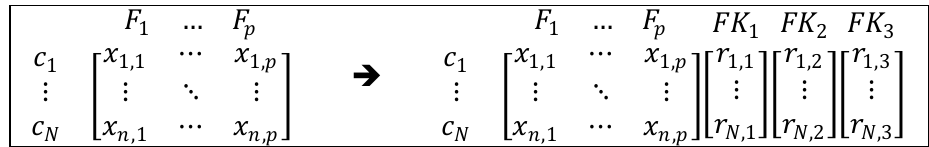
19 of 44 Figure 7. Critical differences plot of the pairwise Nemenyi comparison test for the cut-off (threshold) adaptation experiment. There are many techniques to perform feature selection, which aims to select a subset of salient features to build a prediction model. Bi et al. [99] have attempted feature selection through introducing a probe to the data by adding three randomly generated variables (fake features/columns) to the dataset. These fake features are randomly drawn from a Gaussian distribution [100]. They use a linear SVM to model the subsets at every iteration of a K-folds cross- validation, where variables with nonzero weights are selected. Any variable (feature) with an average weight below that of the fake variables is then rejected. This approach does not address weight variability, as it only compares averages. Similarly, Kursa et al. [101,102] have proposed a similar approach in which the information system (training data) is doubled, so that every feature has a shadow feature that is basically a shuffled version of the original one. Feature importance evaluation is then performed on the extended system using the RF algorithm. A K-folds CV—of at least 10-folds—is performed at every iteration, so that every feature is compared to its shadow using statistical tests to evaluate the highest performing features. The main drawbacks of this approach are scalability and speed. Therefore, in this paper a new approach has been proposed and executed that combines the core ideas of the two approaches above. In this approach, as illustrated in Figure 8, the information system (training data) is extended by adding three randomly generated variables (fake features/columns) to the dataset, where these fake